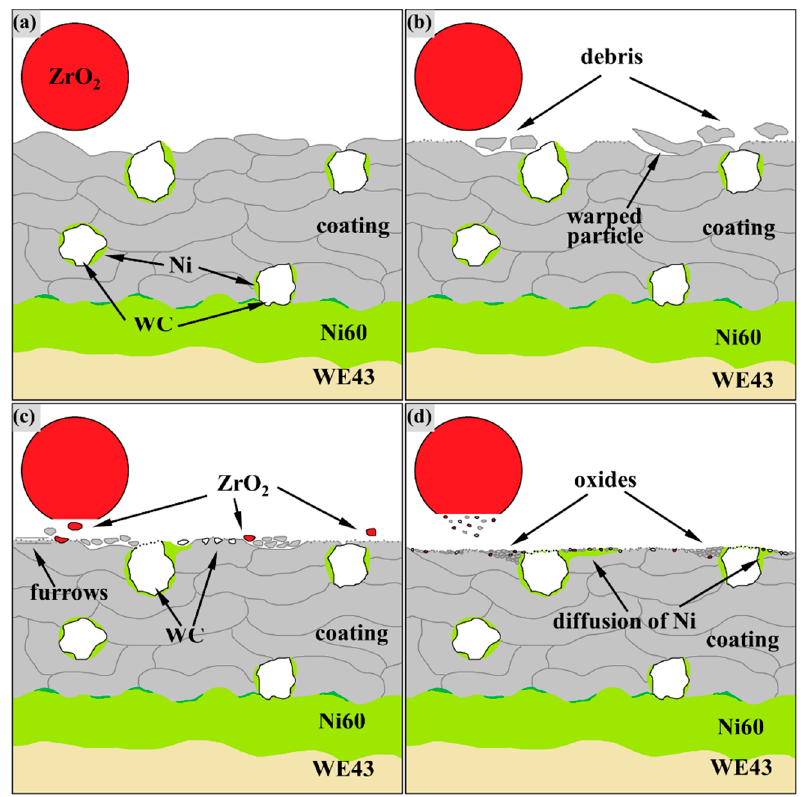
Figure 9. The schematic of amorphous coating wear process: ( a ) the contact of the coating and the ZrO 2 friction ball; ( b ) fragments from sheared protruding particles and warped particles in the running-in stage; ( c ) the fragments are ground into debris, and the Ni layer begins to spread in the middle wear stage; ( d ) the products of oxidation wear are well mixed with the Ni layer after diffusion.